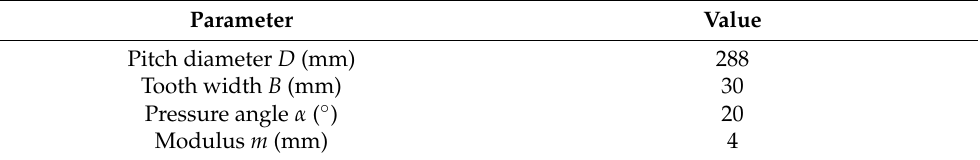
Table 1. Basic parameters of spur